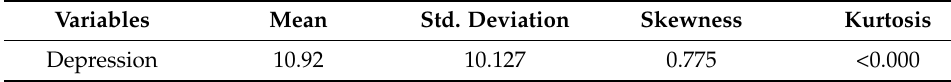
Table 1. The descriptive statistics information.